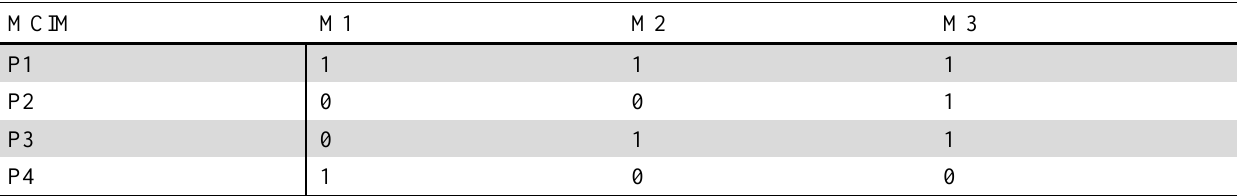
MCIM matrix for experiment number 1